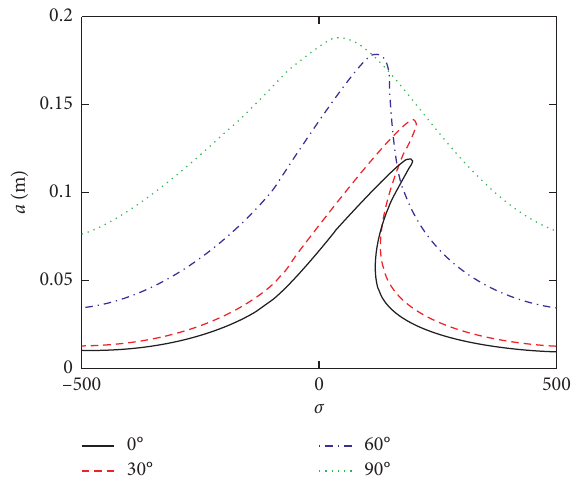
Figure 17: Effect of the ply angle on primary resonance